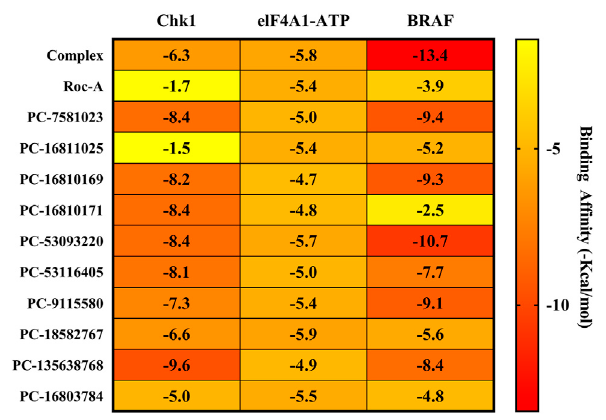
FIGURE 13 | Heatmap plot comparing the experimental, commercial and promissing compounds binding af fi nity ( Δ G) values in receptors: Chk1 (PBD ID 2CGX), elF4A1-ATP (PDB ID 5ZC9) and BRAF (PDB ID